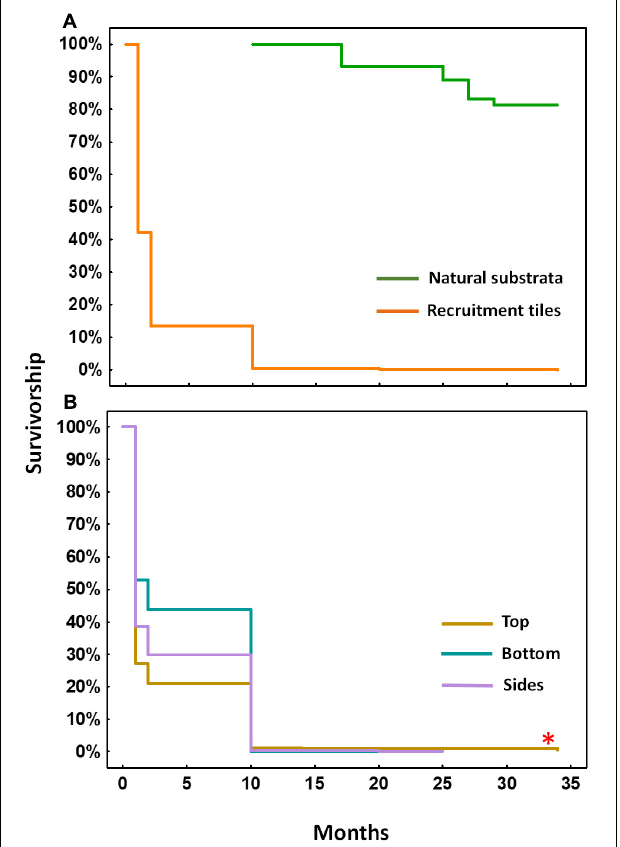
FIGURE 5 | Kaplan-Meier survivorship over 34 months for settled A. tenuis polyps, juveniles and recruits in (A) larval enhanced plots on tiles (orange) and for visible recruits on natural reef substrata (green) starting at 10 months after larval settlement, and (B) survivorship of recruits on different tile surfaces in the larval enhanced plots. Asterisk denotes significant difference between tile